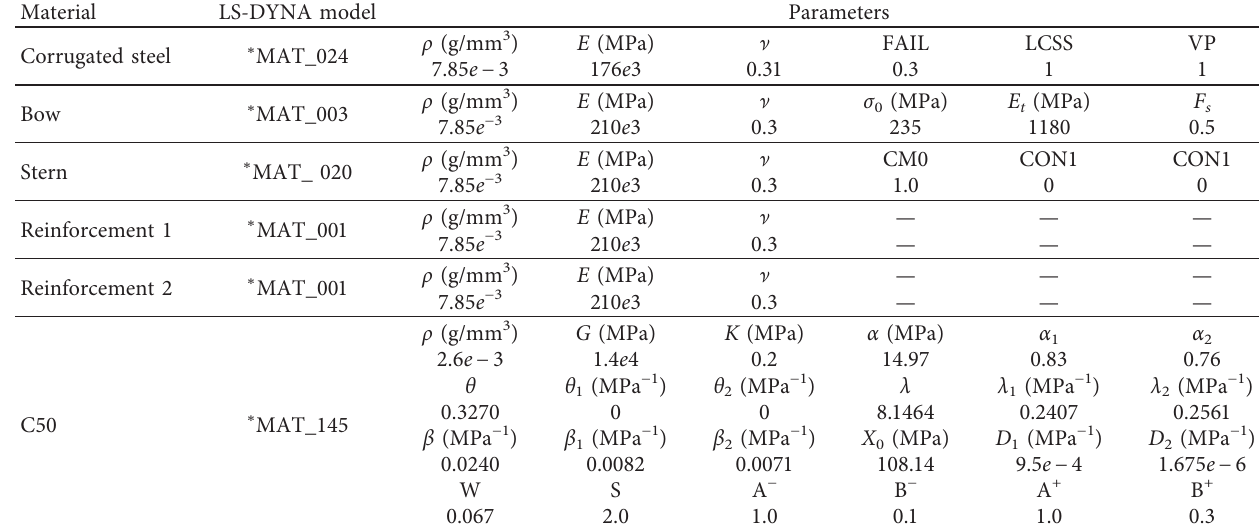
Figure 2: CSP geometric model (unit: mm): (a) elevation view of CSP, (b) plan view of CSP, (c) B detailed drawing of connected part, (d) C detailed drawing of the M12 high-strength bolt connection, and (e) A–A sectional view. Table 1: Parameters of the